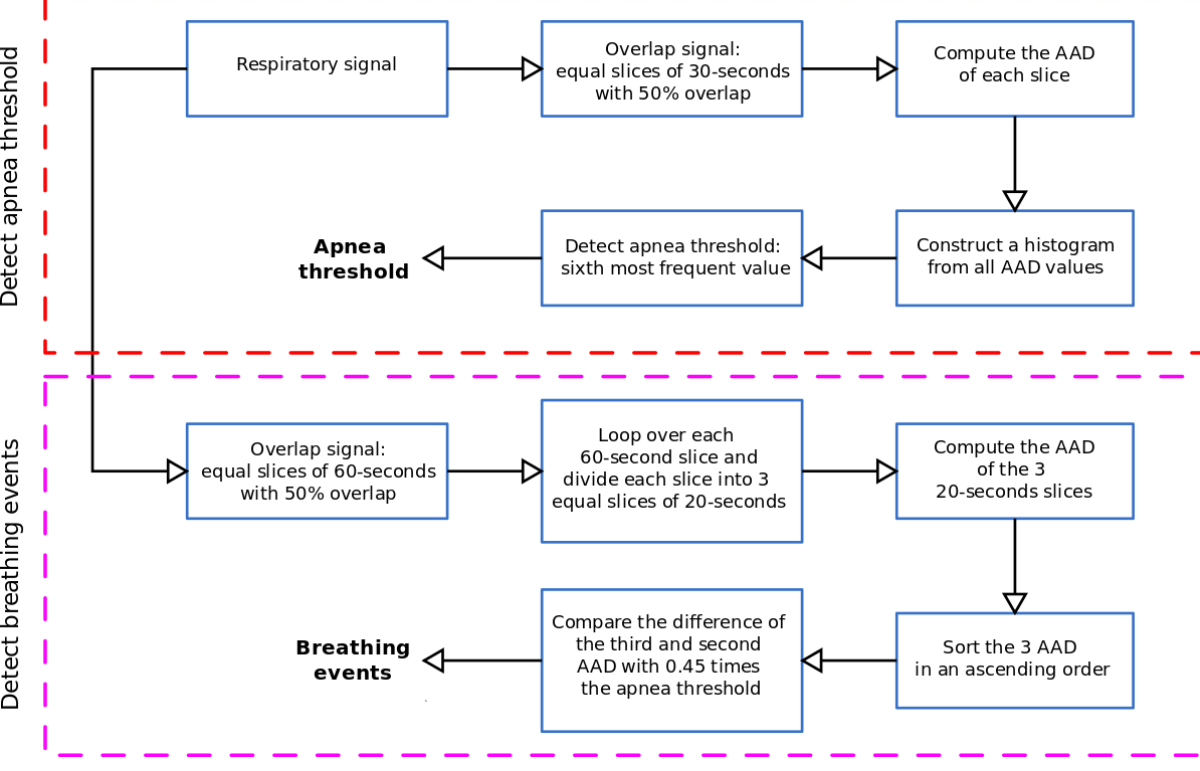
Figure 6. Flowchart of apneic event detection. AAD: average absolute